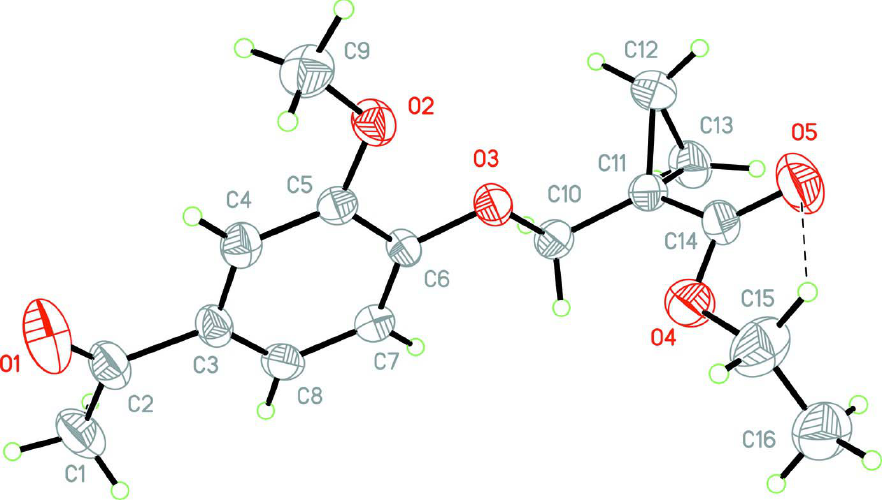
A drawing of the molecular structure of (I), with the atom-numbering scheme. Displacement ellipsoids are drawn at the 40% probability level. Intramolecular C—H···O hydrogen bond is shown as a dashed